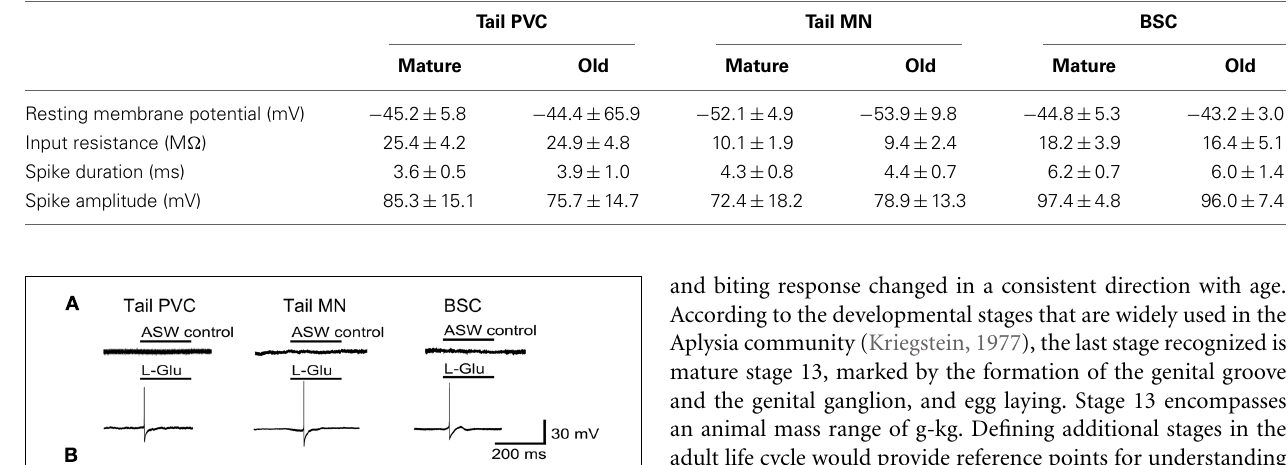
Table 1 | Resting membrane potential, input resistance, spike duration, and spike amplitude were not significantly different in intact neuronal preparations during aging.